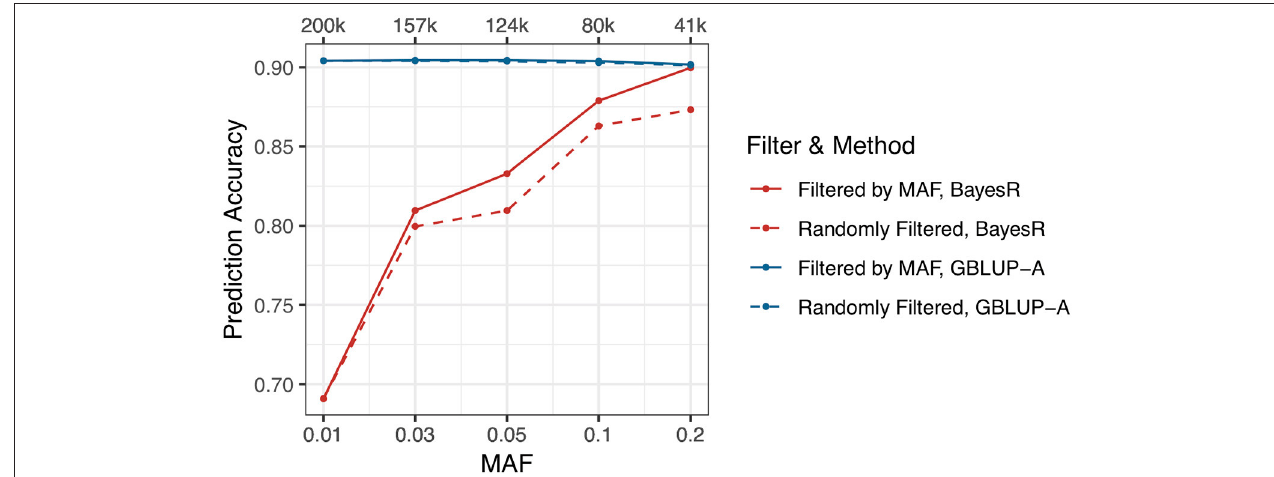
FIGURE 3 | Effect of MAF on the prediction